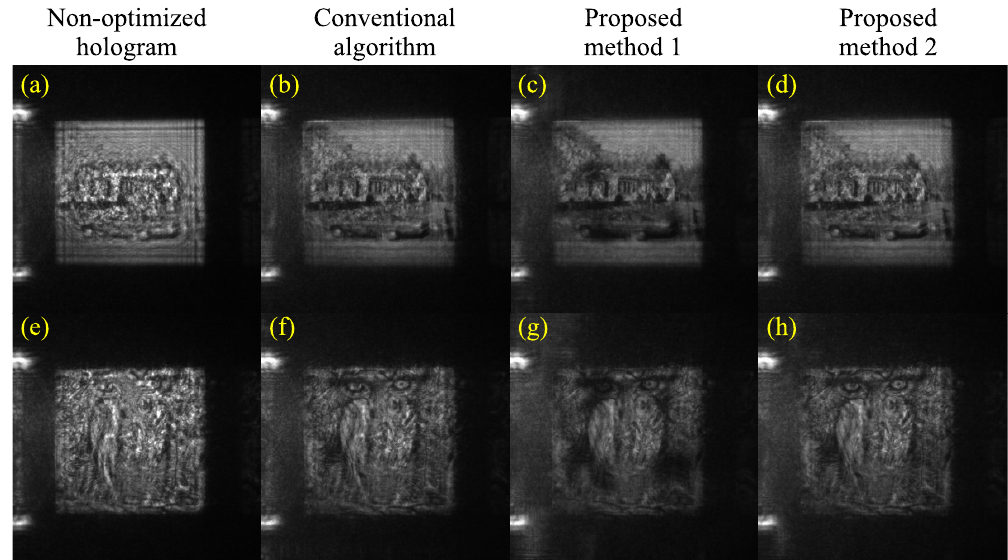
Figure 9. Optical reconstructions from holograms with 1024 × 1024 pixels: ( a , e ) show reconstructed images obtained from the non-optimized hologram, ( b , f ) show reconstructed images obtained from the conventional algorithm, ( c , g ) show reconstructed images obtained from the proposed method 1, and ( d , h ) show reconstructed images obtained from the proposed method